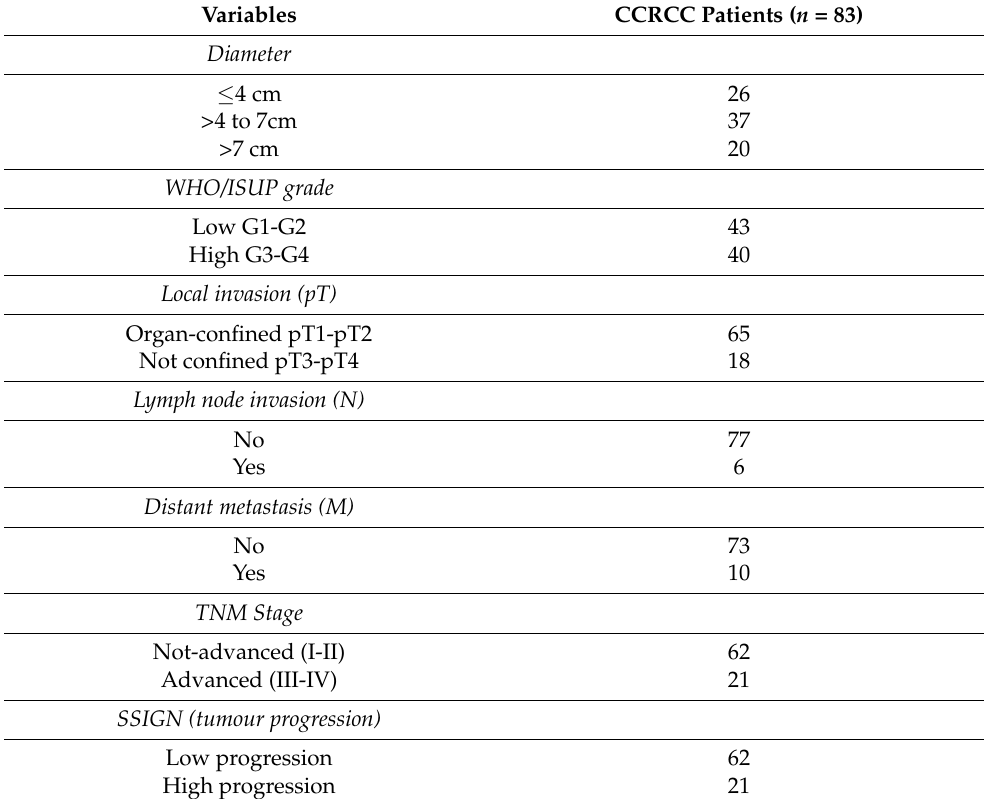
Table 1. Pathological and clinical characteristics of clear cell renal cell (CCRCC) cancer patients. WHO/ISUP: World Health Organization / International Society of Urologic Pathologists. TNM: Tumour (T), Node (N), Metastasis (M). SSIGN: Stage, Size, Grade, and Necrosis. UISS: UCLA Integrated Staging